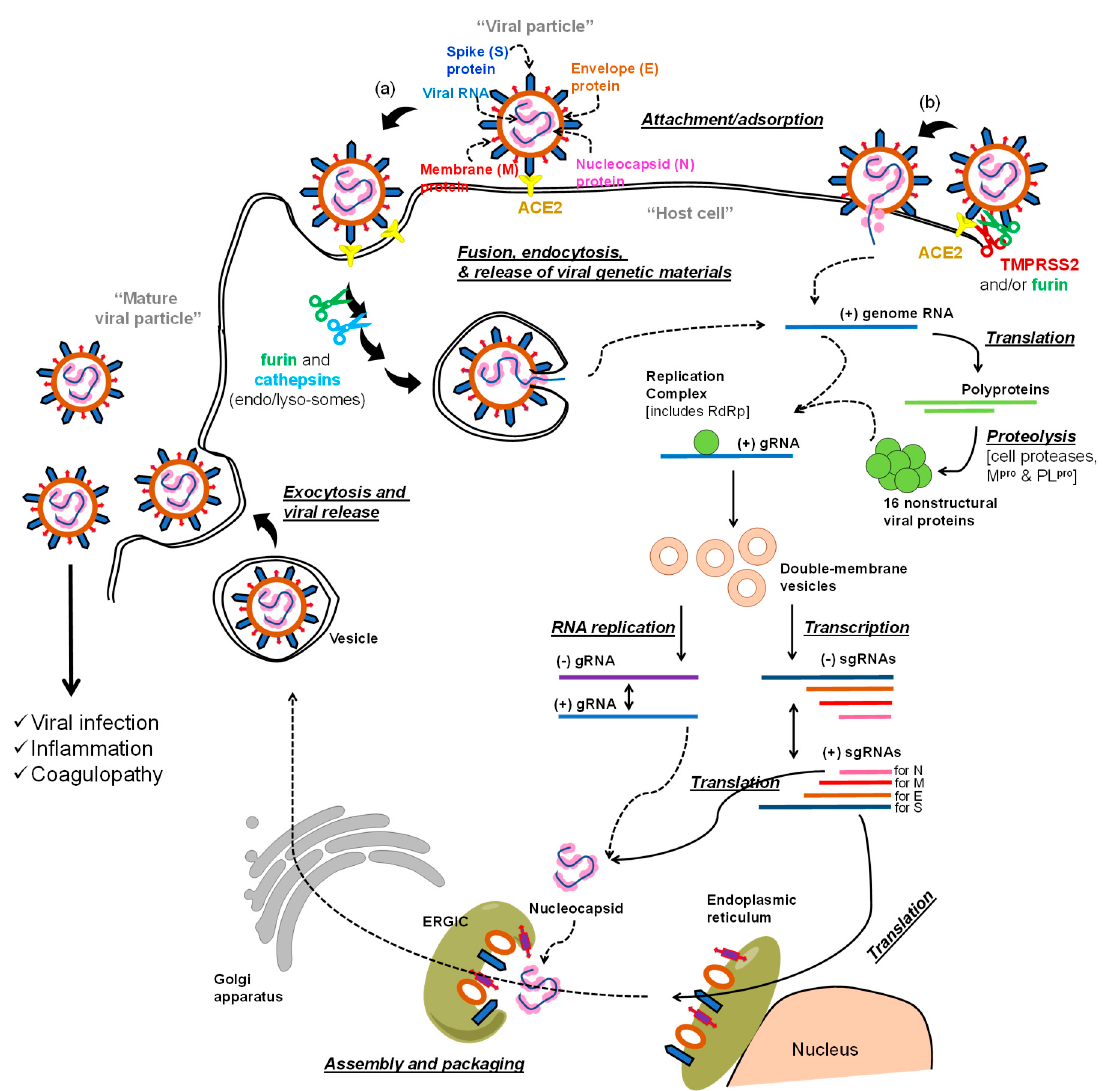
Figure 1. Representation of the viral particle of SARS-CoV-2 demonstrating the structural proteins: S (blue), E (brownish orange), M (red), and N (pink). It also details the post-entry stages of the life cycle of the virus. Following the release of the viral RNA genome to the host cell environment, the nonstructural proteins (NSPs) domain is expressed as two polypeptides and eventually produce PL pro , M pro (also known as 3CLpro), and RdRp. Initial processing of the two polypeptides is by host proteases and then is propagated by PL pro and M pro . The viral RdRp is also responsible for the replication and amplification of the viral genome. The viral RNA and the N structural protein are biosynthesized in the host cell cytoplasm, whereas viral structural proteins S, M, and E are biosynthesized in the endoplasmic reticulum and transported to the Golgi apparatus. The viral RNA–N complex and S, M, and E proteins are assembled in ERGIC. The mature virus is produced by the budding process. The virus is then released by exocytosis. Note: The virus enters via membrane fusion in the endo/lyso-somes which requires proteolytic activation by cathepsins ( a ) or via fusion at the cell membrane which requires proteolytic activation by TMPRSS2 ( b ). Furin may also contribute to the entry of the virus, yet its site of action is not fully established. gRNA means genomic RNA and sgRNA means subgenomic RNA.